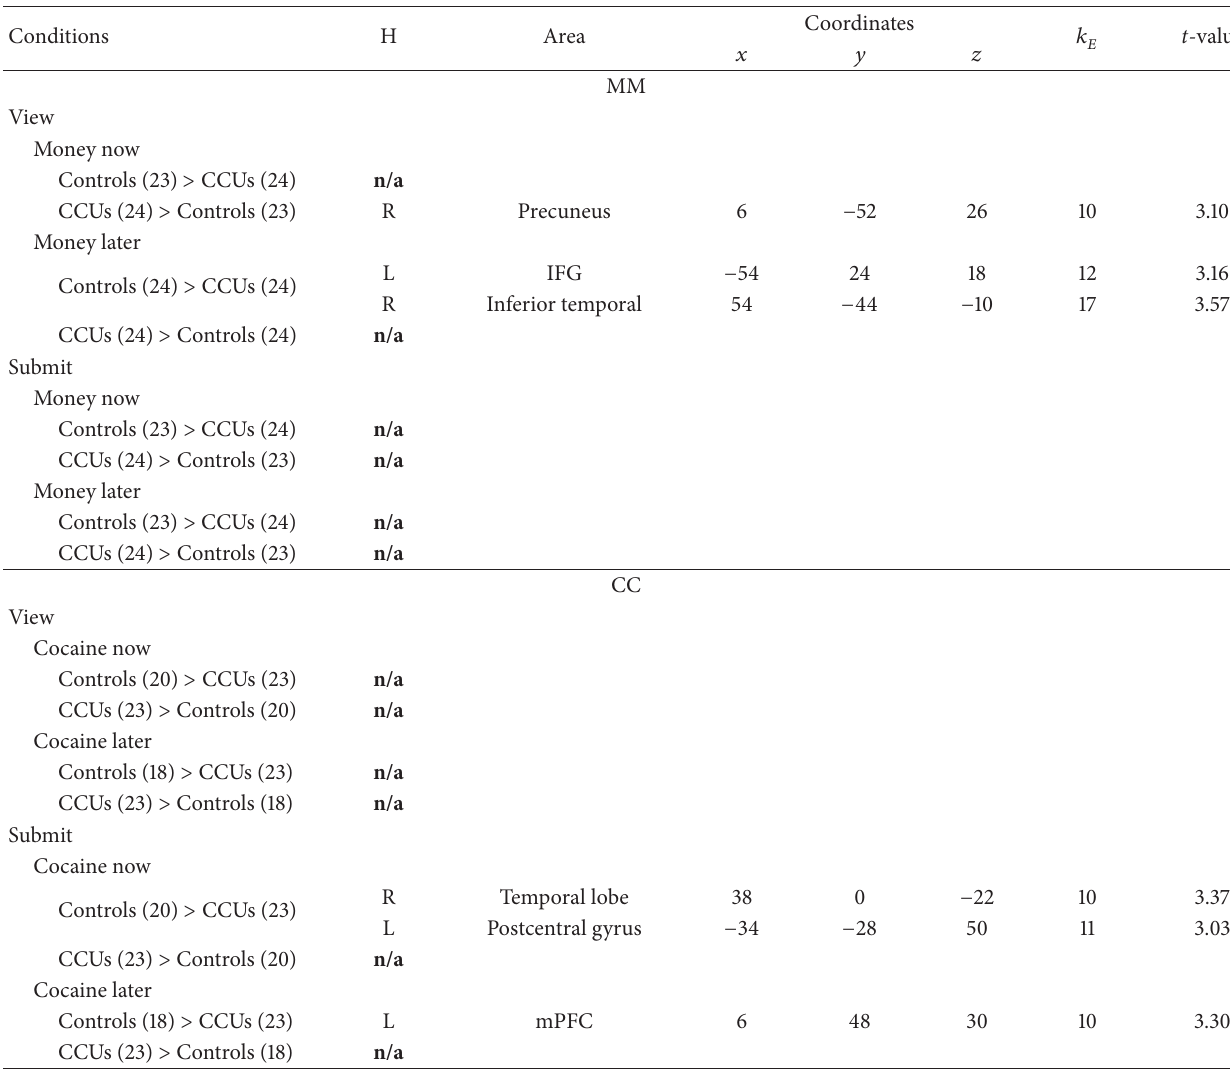
Table 1: Areas of significant BOLD signal differences between controls (Controls) and chronic cocaine users (CCUs) while viewing and submitting choices during single-commodity blocks of money now versus money later (MM) and cocaine now versus cocaine later